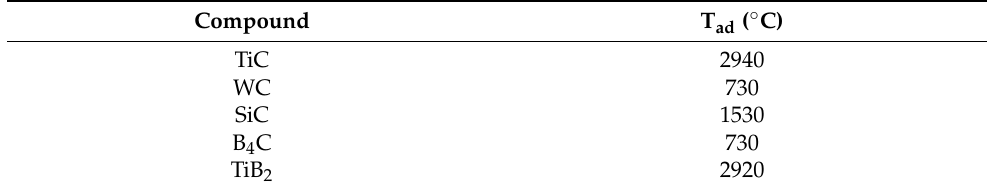
Table 1. Adiabatic temperature (T ad ) of carbides and borides (adapted from [32,34]).